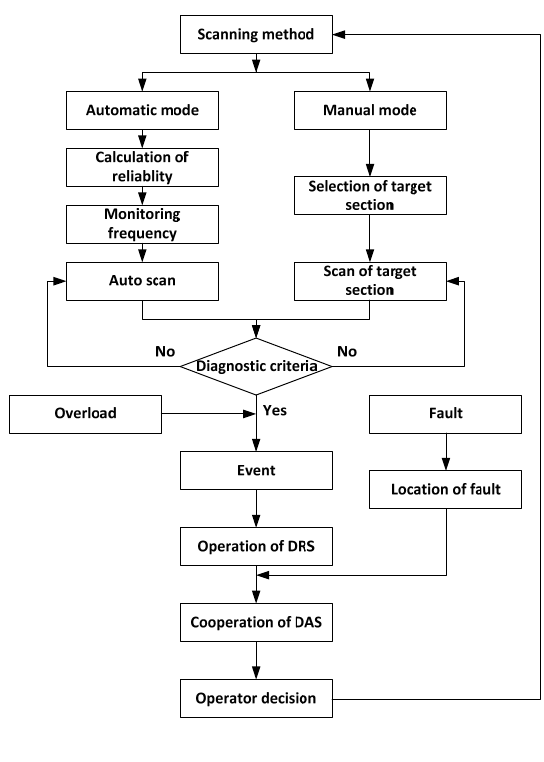
Figure 6. Algorithm of operation program.